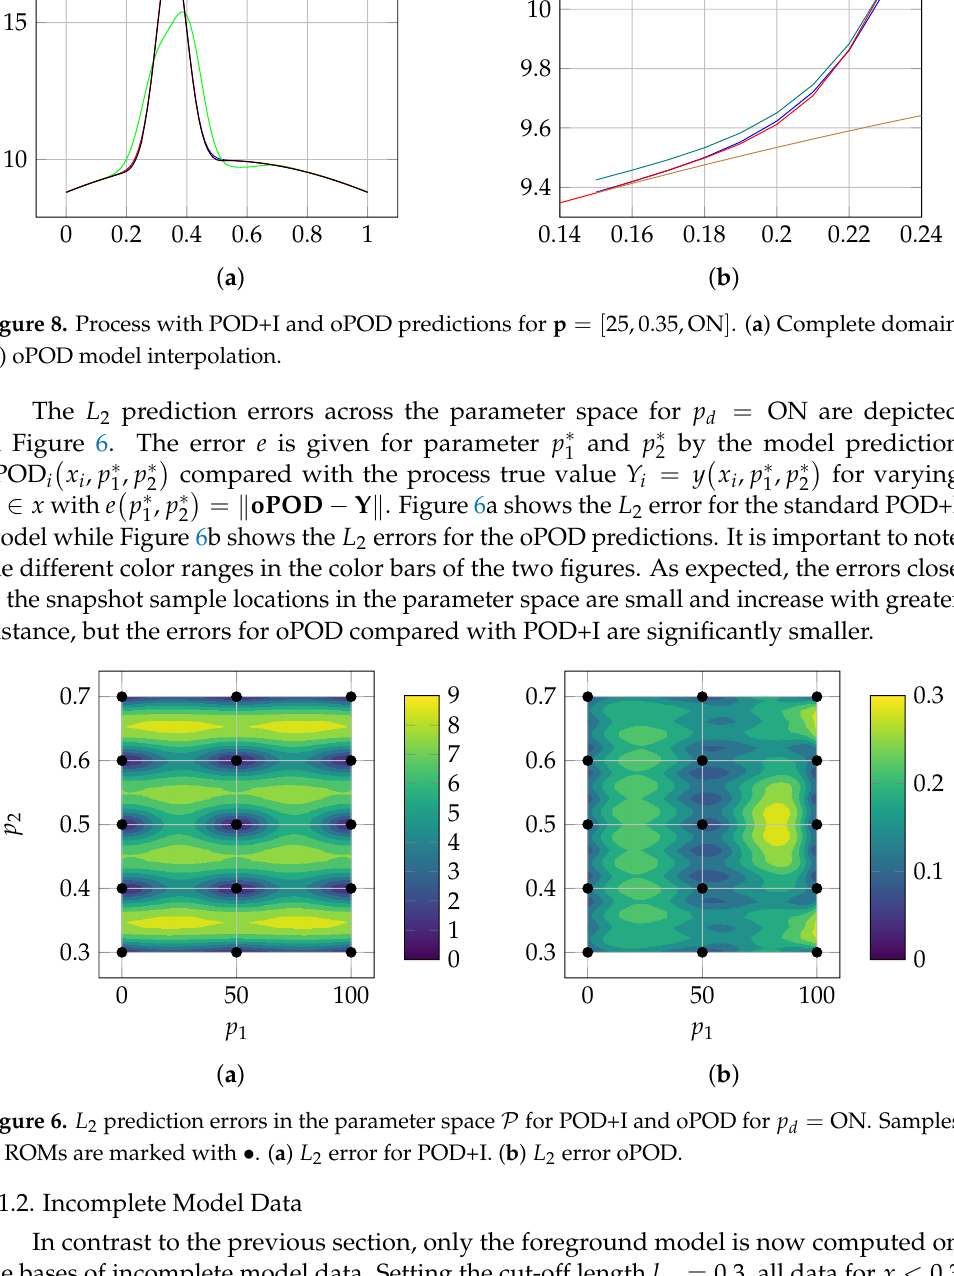
Figure 6. L 2 prediction errors in the parameter space for POD+I and oPOD for p d = ON. Samples of ROMs are marked with . ( a ) L 2 error for POD+I. ( b ) L 2 error •